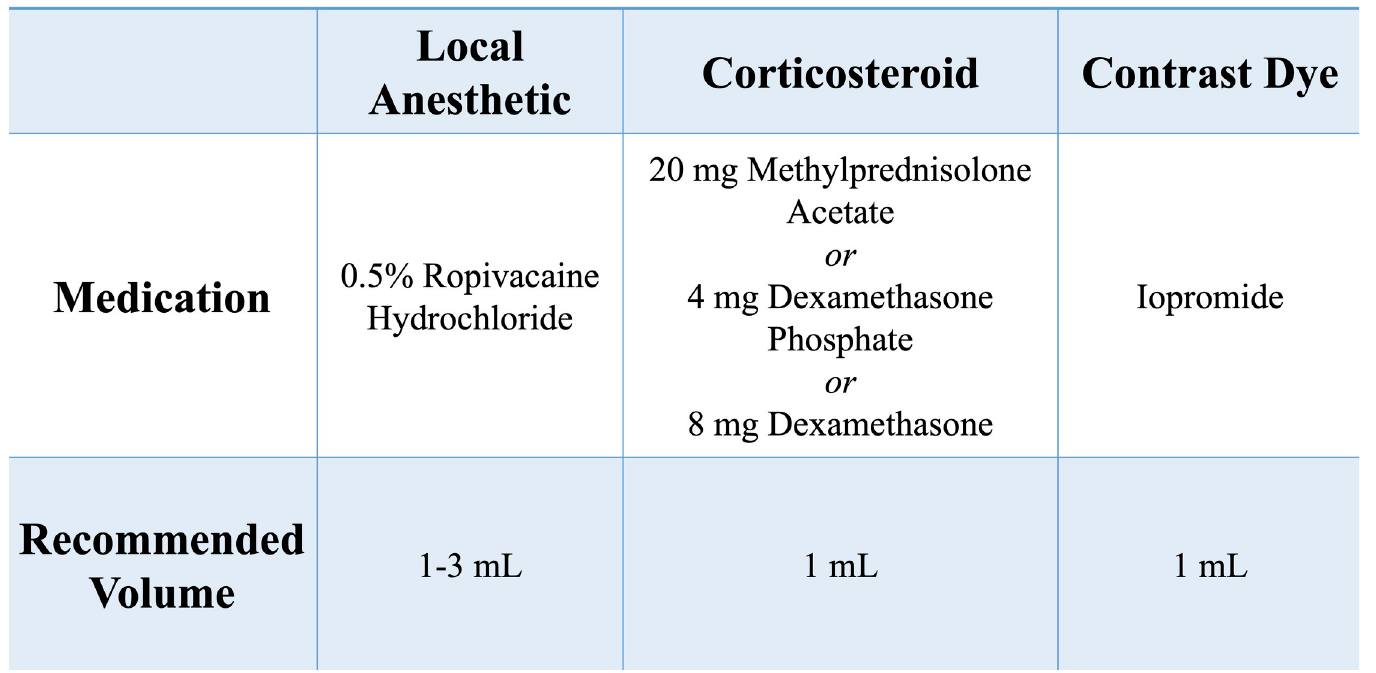
Fig 6. Hip IACSI medication recommendations based on best-available evidence literature review and local/community standards.